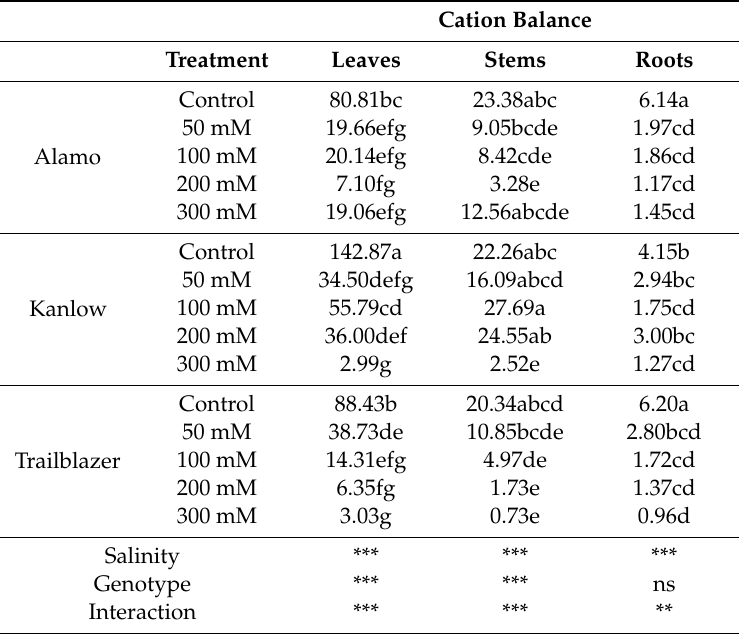
Table 7. The cation balance ((K + Ca + Mg) / Na) in the leaves, stems and roots of Alamo, Kanlow and Trailblazer genotypes of Panicum virgatum subjected to the control, 50, 100, 200 and 300 mM NaCl treatments at 180 DAP. Cation Balance Treatment Leaves Stems Roots